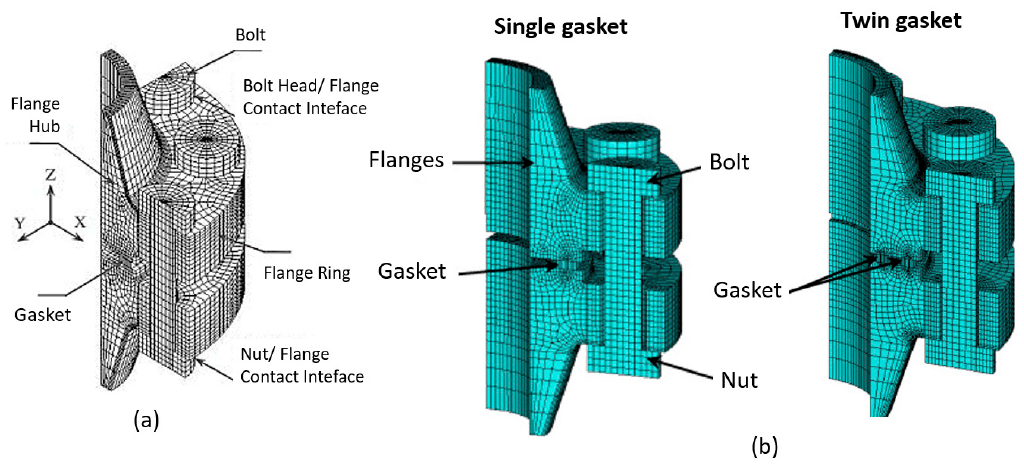
Figure Figure 31. Typical application involving gaskets, ( a ) Reproduced with permission [241] and ( b ) Reproduced with permission [242].